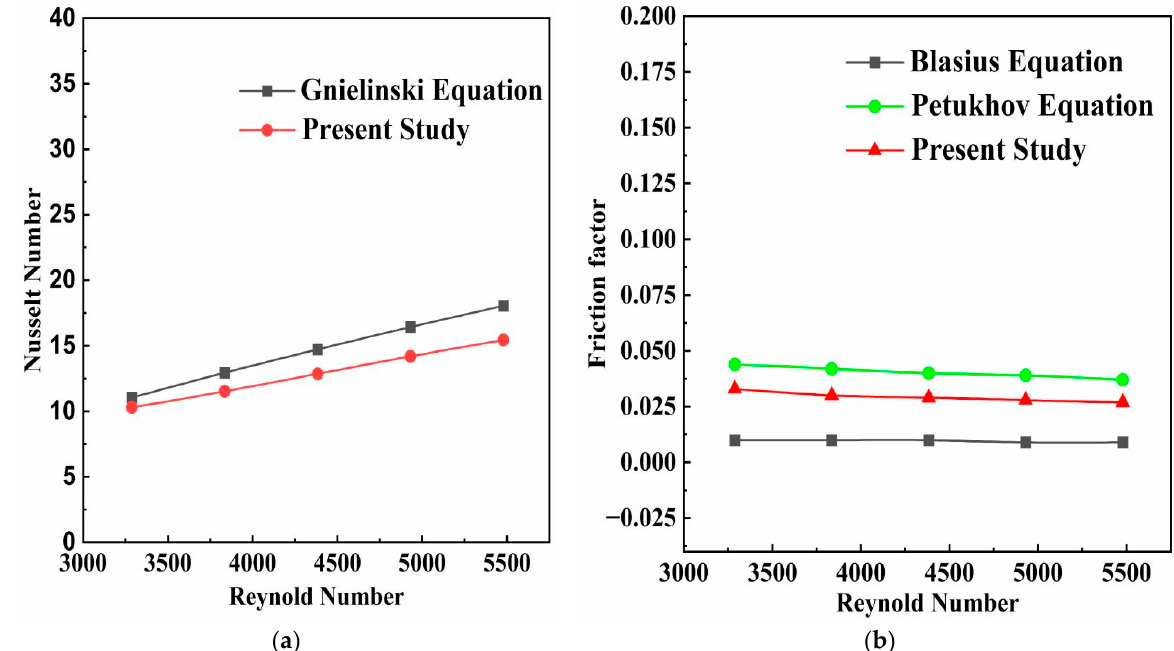
Table 7. Correlation equations for the verification of the empty channel SAH .